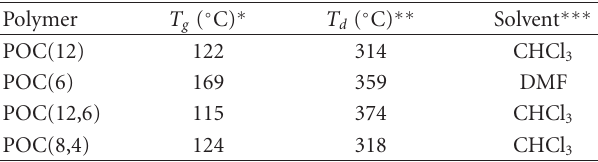
Table 1: Features of